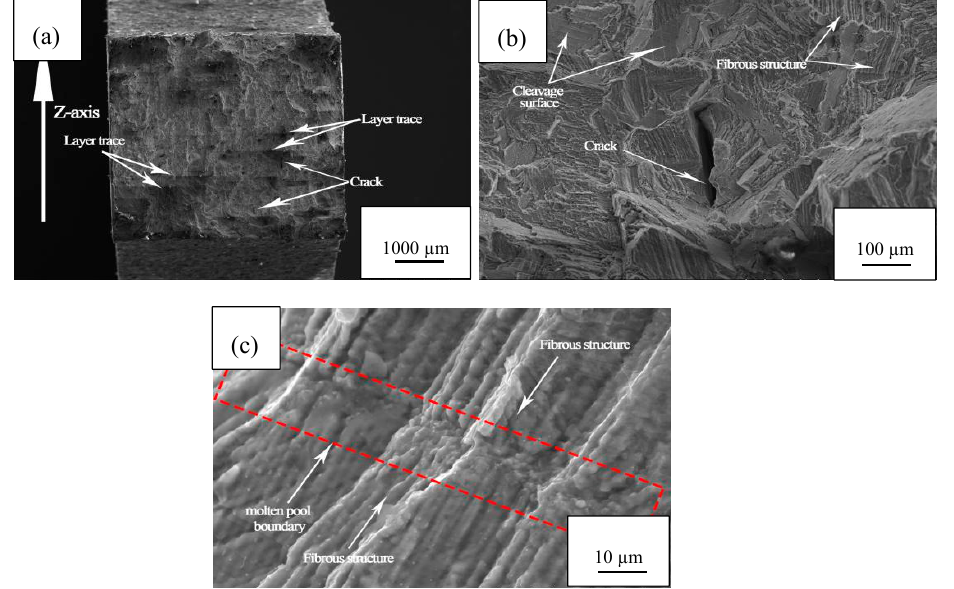
Figure 12. Fracture morphology of SLM cobalt-chromium alloy at different magnifications: ( a ) 1000 μ m; ( b ) 100 μ m; ( c ) 10 μ m.